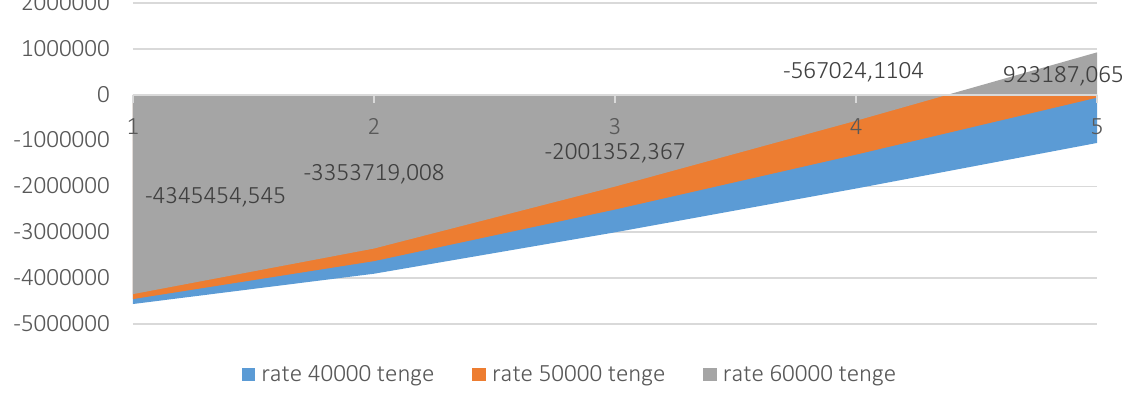
Figure 1. Dynamics of net cash flow for different tariff Table 8. Calculation of the payback period of the SaaS product “3D-quarry” (the cost of an annual subscription is 50,000 tenge)